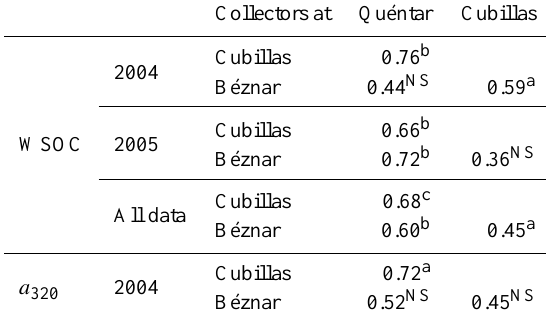
Table 3. Correlation coefficients between the different atmospheric collectors for total deposition of water-soluble organic carbon (WSOC) and their absorption coefficients at 320nm ( a 320 ) .